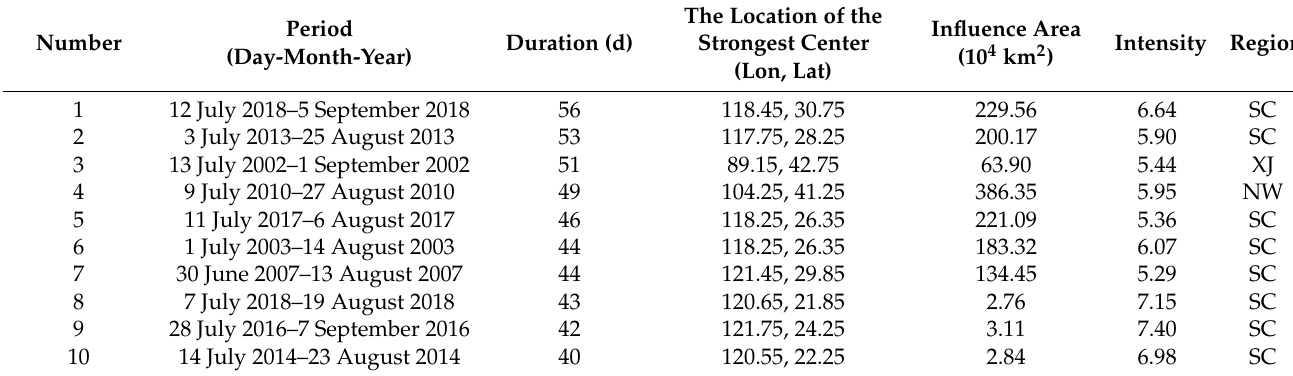
Table 4. List of top ten heatwave events ranked by duration in the 1979–2018 period in